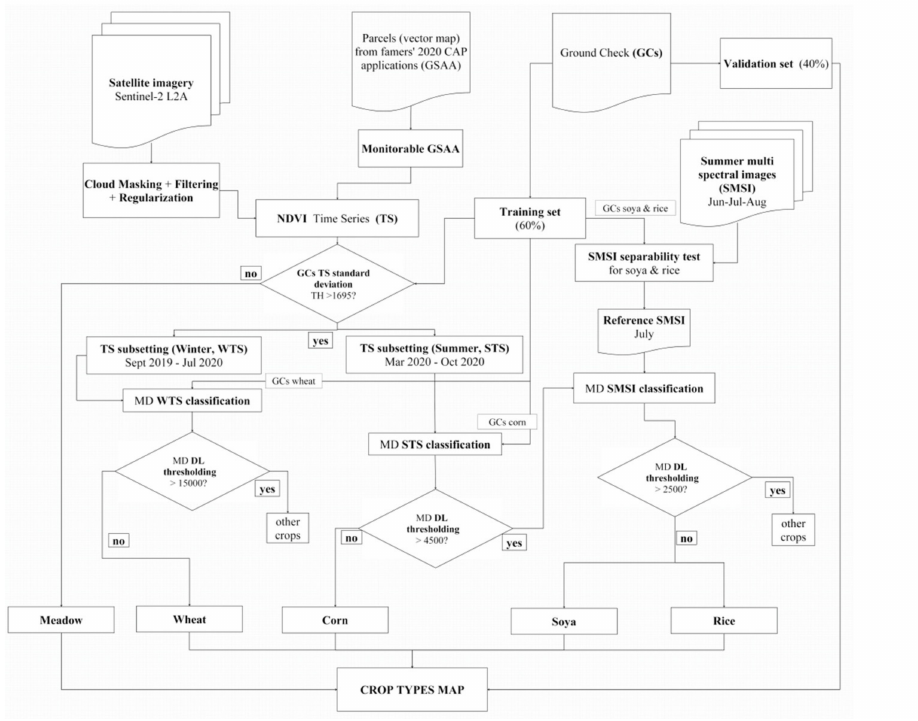
Figure 4. Workflow of the proposed hierarchical classification process concerning crop